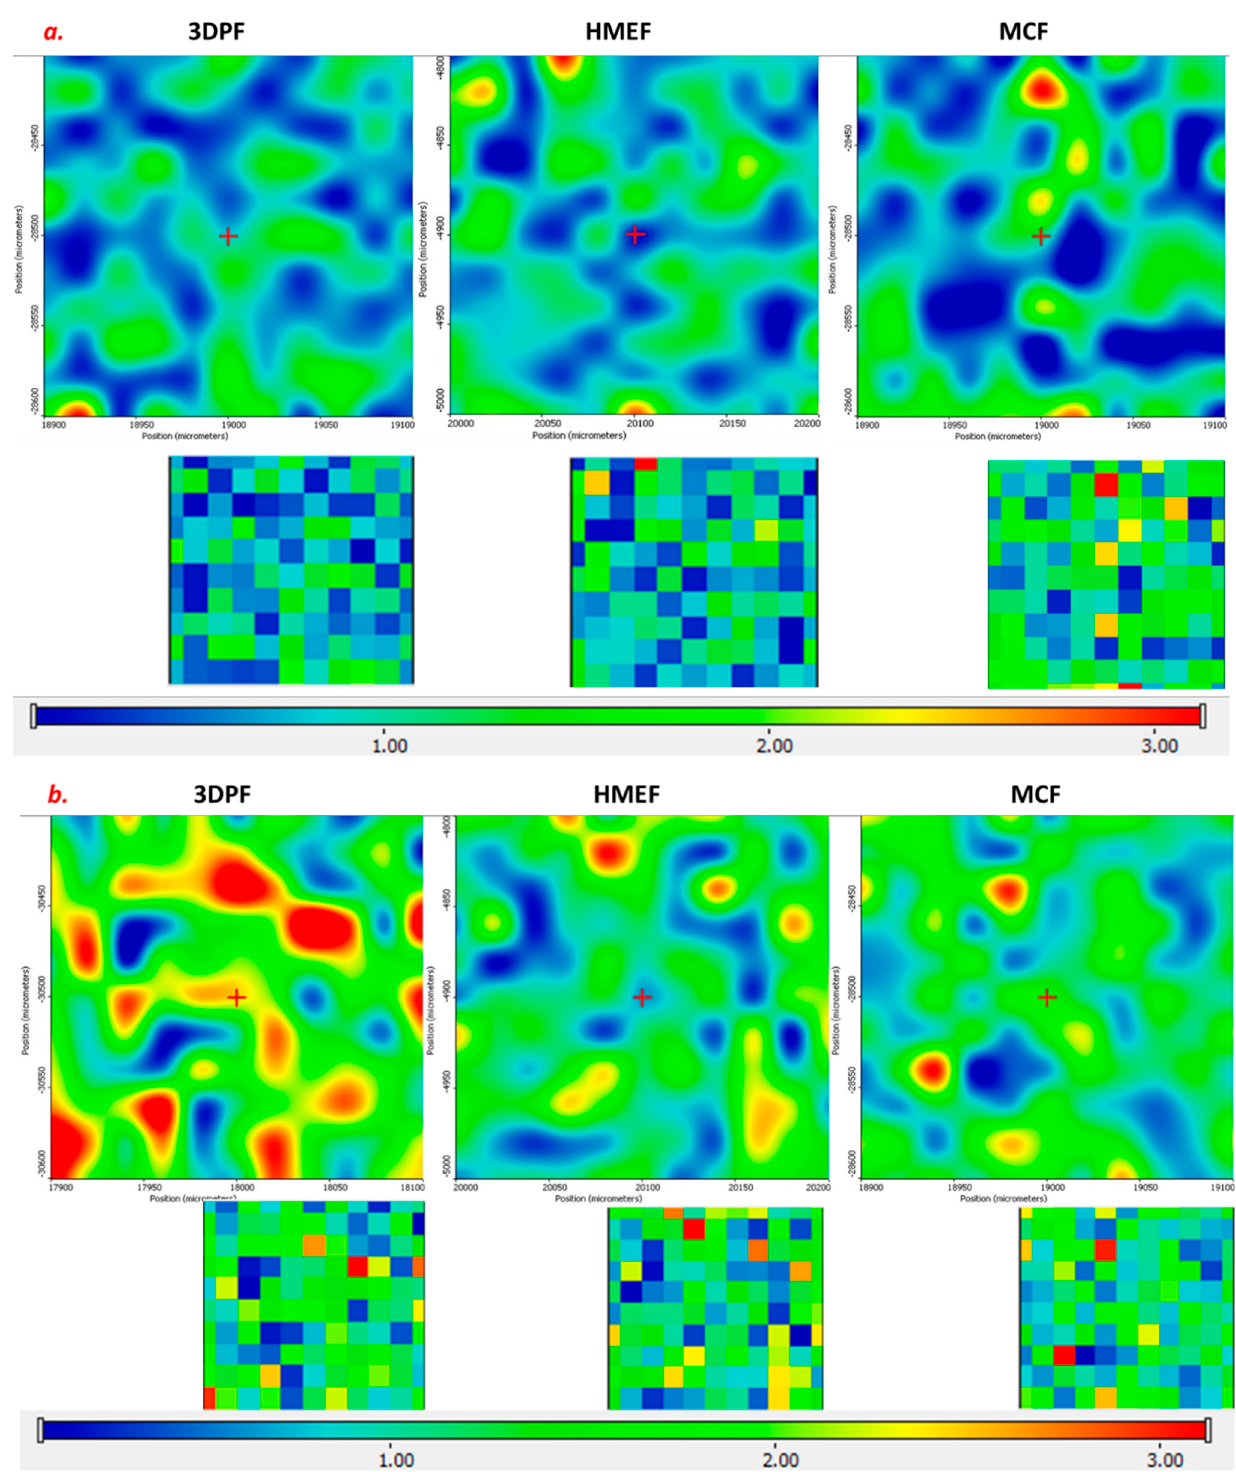
− 1 ; and ( b ) 1656 cm − 1